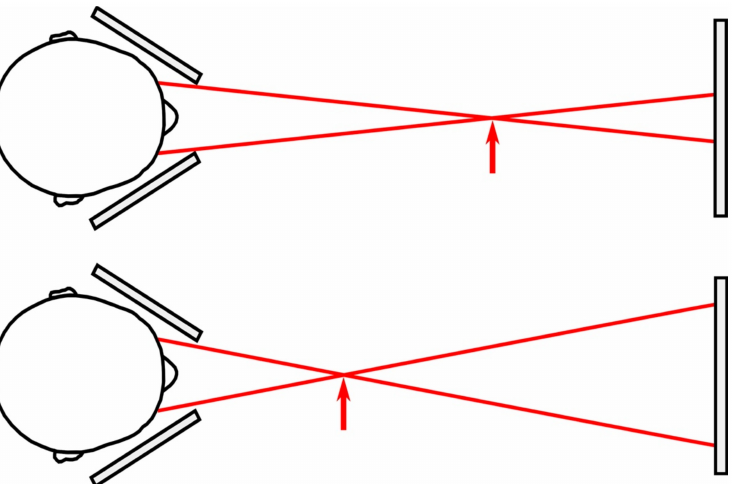
Figure 2. Illustration of how the vergence specified distance was manipulated in the experiment using a fixed display. By increasing the separation between the targets on the display (top vs. bottom image) we were able to reduce the vergence specified distance (indicated by